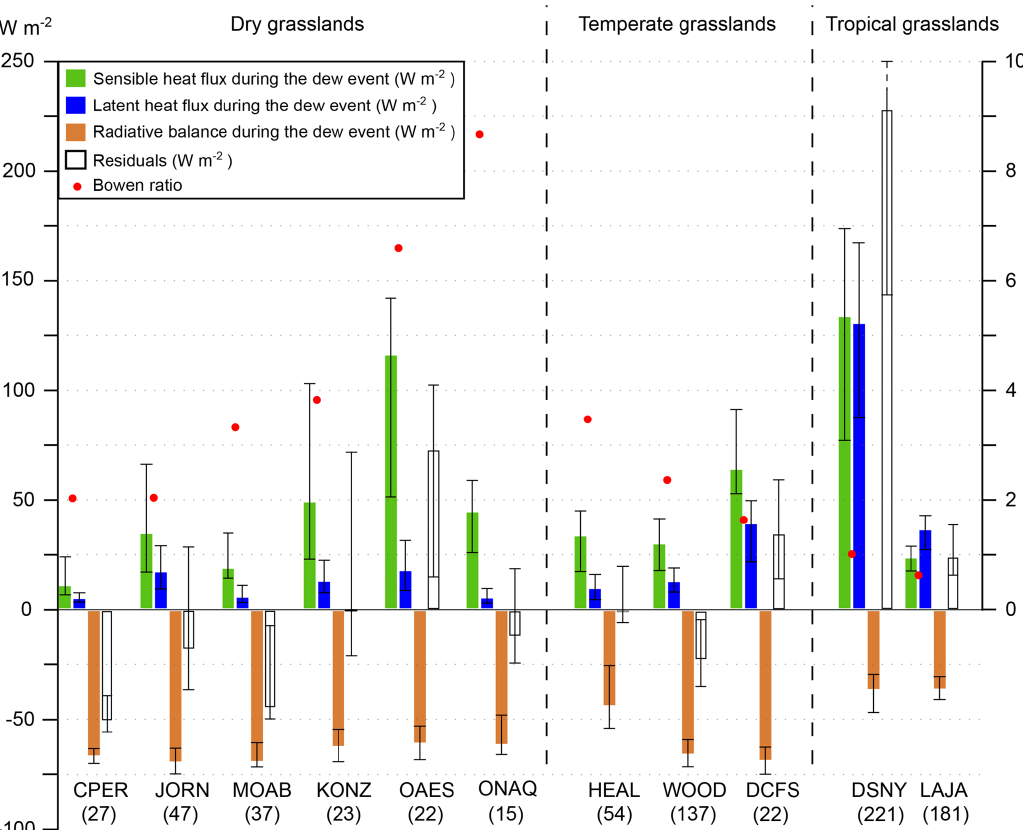
Figure 6. Median value and [ 25 , 75 ] % quantiles (error bars) of the net radiation above canopy ( R n ), and the sensible ( H ) and latent heat fluxes (LE) averaged during a dew event for each dewy night (indicated in parenthesis). The sign convention is positive when the grassland receives energy, and the residuals are R n + LE + H , with R n measured and LE and H calculated with the Monin–Obukhov similarity